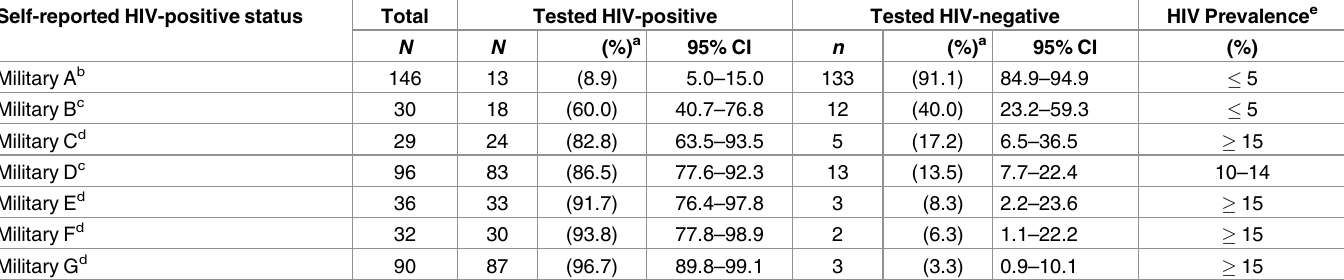
Table 1. Military-specific prevalence of testing HIV-positive using the rapid diagnostic test algorithm among those who self-reported being HIV-